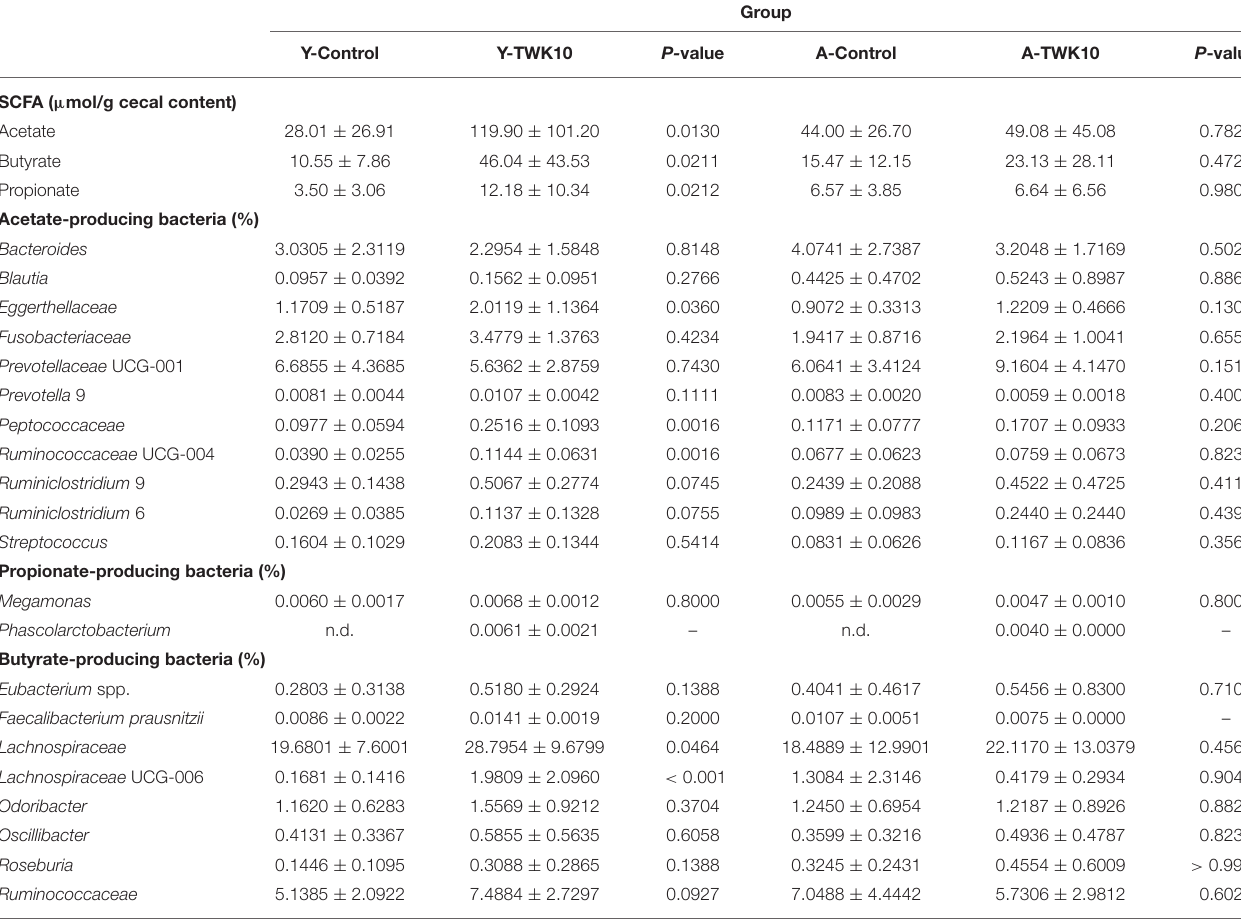
TABLE 3 | Lactobacillus plantarum TWK10 enriched SCFA-producing gut bacteria and promoted the production of